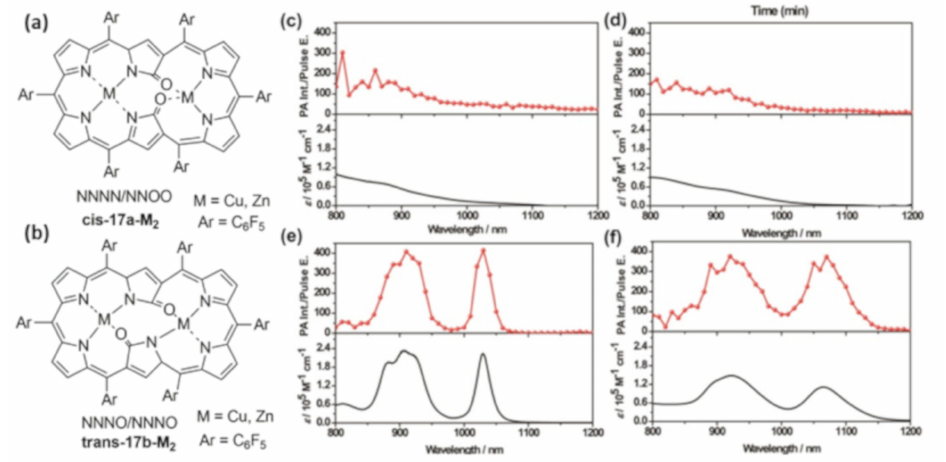
Figure 13. Structures of ( a ) cisoid- ( b ) transoid-metallodioxohexaphyrin metal complexes; ( c - f ) PA (top, red) and absorption (bottom, black) spectra (in dimethyl formamide) of ( c ) cis-17a-Zn 2 , ( d ) cis-17a-Cu 2 , ( e ) trans-17b-Zn 2 and ( f ) trans-17b-Cu 2 (adapted with permission from Reference [108]. Copyright: (2020) American Chemical